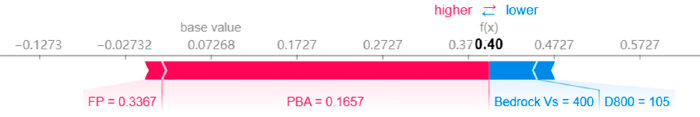
Figure 16. Force plot of the typical sample for XGBoost.